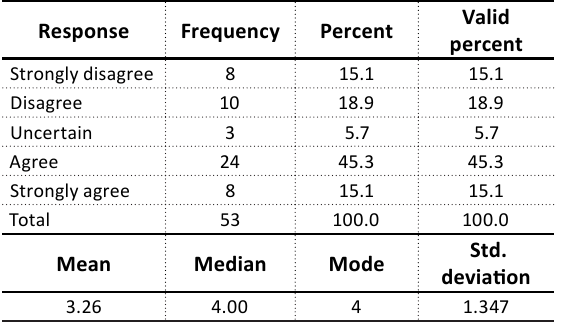
Table 2. Implementation of green HRM practices